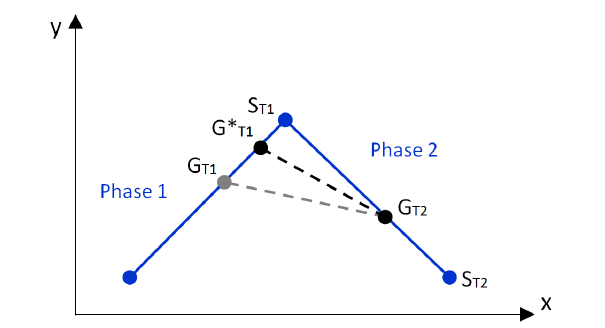
Figure 5 . Algorithm: Compensating the latency error